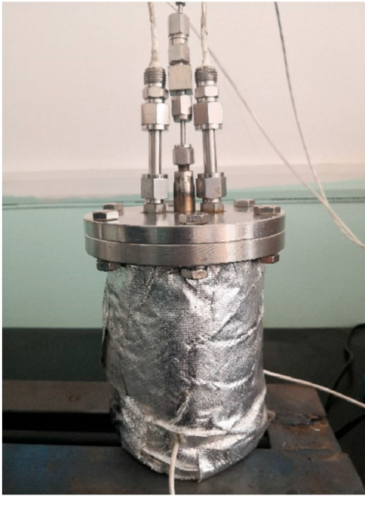
Figure 2. Photo of sample